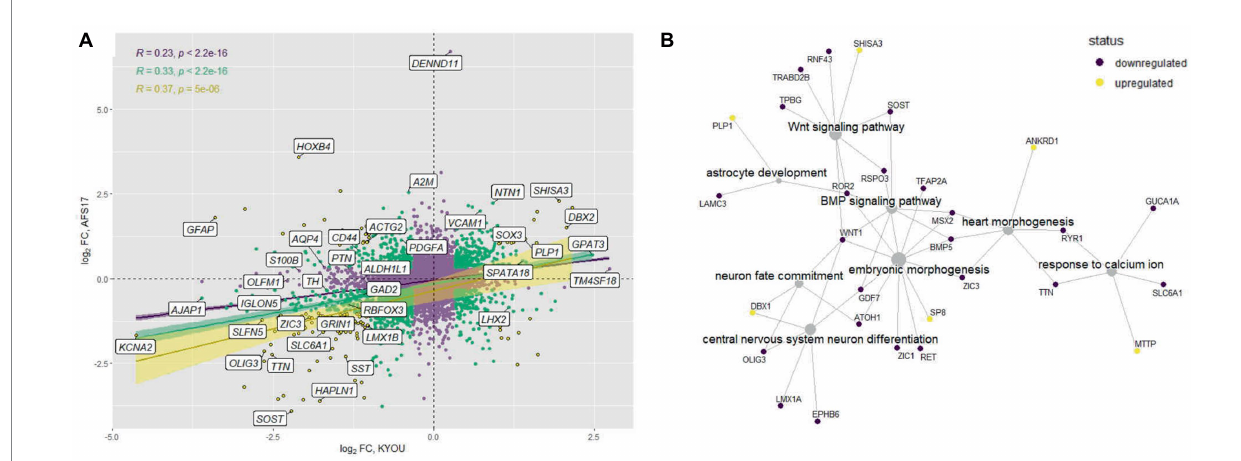
FIGURE 6 Joint analysis of DEG results for the two cell lines. (A) Comparison of DEG results for the two cell lines. Each point represents a gene in a log2 fold change coordinates for N-KYOU and N-AFS17 cultures. Yellow points represent genes with expression changes as big as abs(log 2 fold change) > 1 in both experiments, green points -- abs(log 2 fold change) > 0.33, violet points -- all other genes. Also shown are correlation coefficients, p -values for correlation tests (“pearson”) and linear fit models with 95% confidence level intervals for corresponded color-coded gene subset (violet for all genes, green for “violet” and “green” genes, yellow for “yellow genes only”). Specific genes are the same as specific genes on the volcano plots on Figures 2D,E. (B) Representative graph of gene ontologies and corresponding DEGs ( p-level < 0.05) in both experiments with matched directions of effect. Yellow nodes denote genes with expression rising with number of passages, dark purple nodes represent genes with expression falling with number of